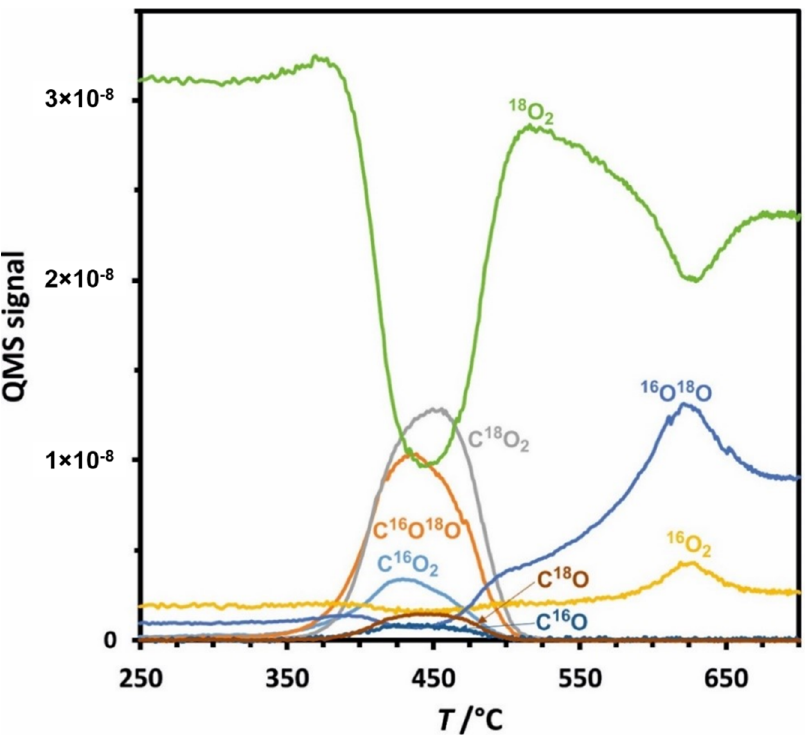
Figure 8. Soot combustion in 18 O 2 in tight contact as a function of temperature on Nb/K-OMS-2 containing 7 wt% of Nb.